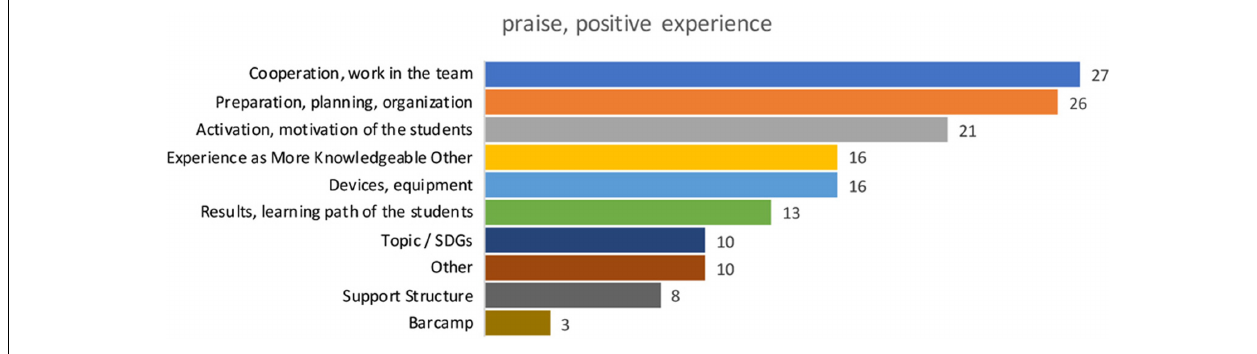
Frontiers in Education |